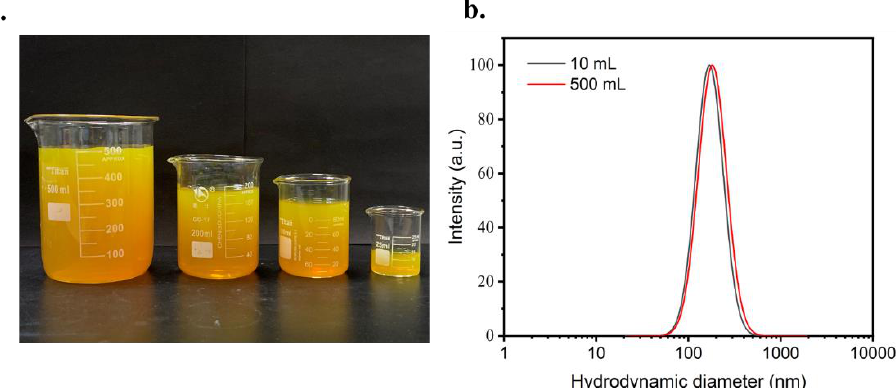
Figure 3. ( a ) Digital photograph of Cur-loaded CS nanocomplex solutions with different volumes of (10, 100, 200 and 500 mL) prepared FNC. ( b ) DLS results of samples with cumulative volumes of 10 and 500 mL by continuous FNC operation.